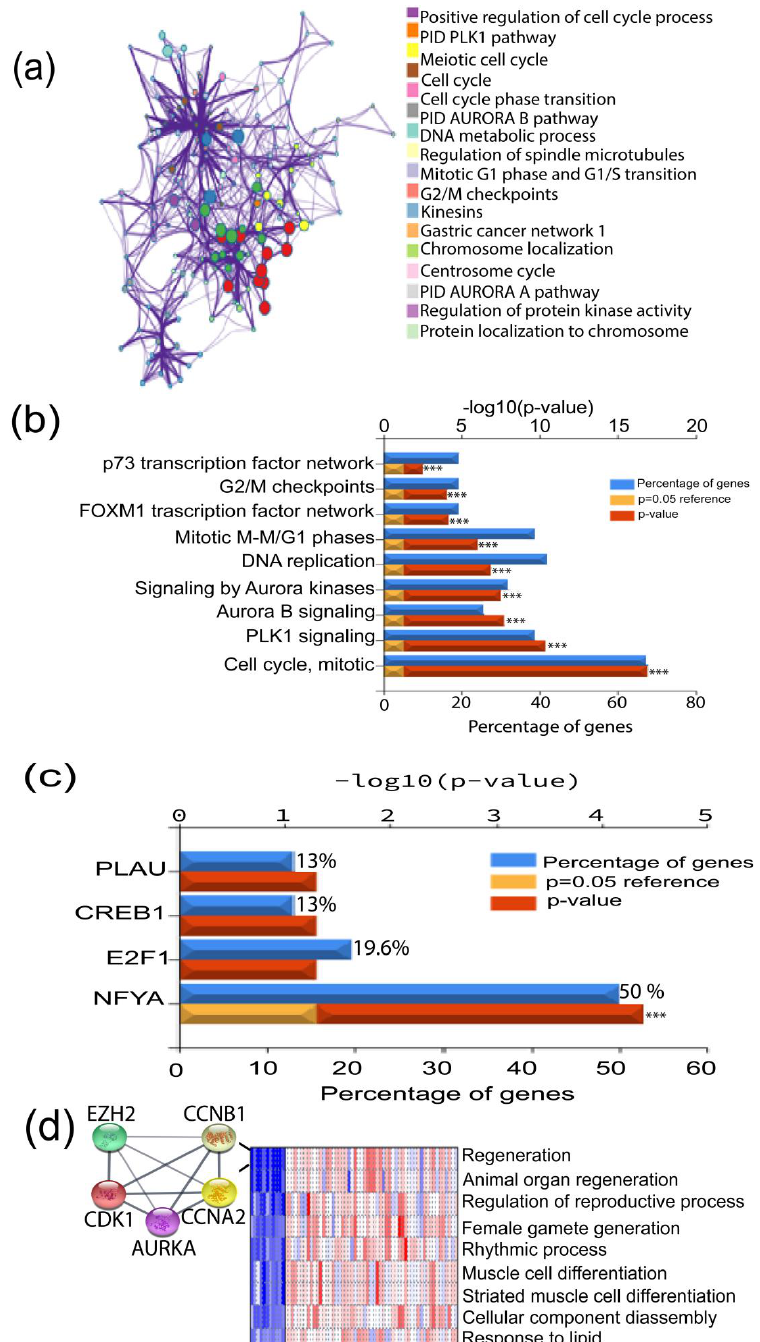
Figure 3. Functional analysis of the 64 common genes identifies a stemness-associated gene signa- ture. ( a ) PPI network of the common differentially expressed genes in the training and validation datasets; ( b ) analysis of differentially expressed gene GO-biological processes pathways enrichment; ( c ) enriched TFs associated with the 55 upregulated differentially expressed genes ( p ≤ 0.001—***); ( d ) PGSEA analysis of the biological processes likely affected by the 55 upregulated and 9 downregu- lated differentially expressed genes based on their expression patterns in different samples, leading to identification of five genes involved in CSCs